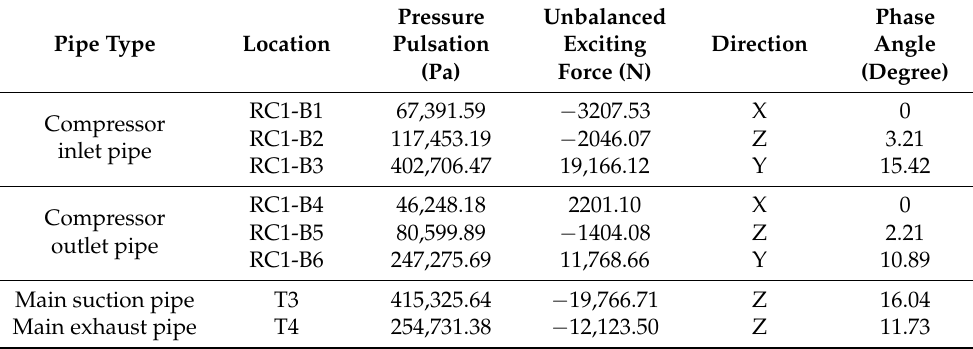
Table 3. Calculation results of unbalanced exciting force caused by RC2 compressor.